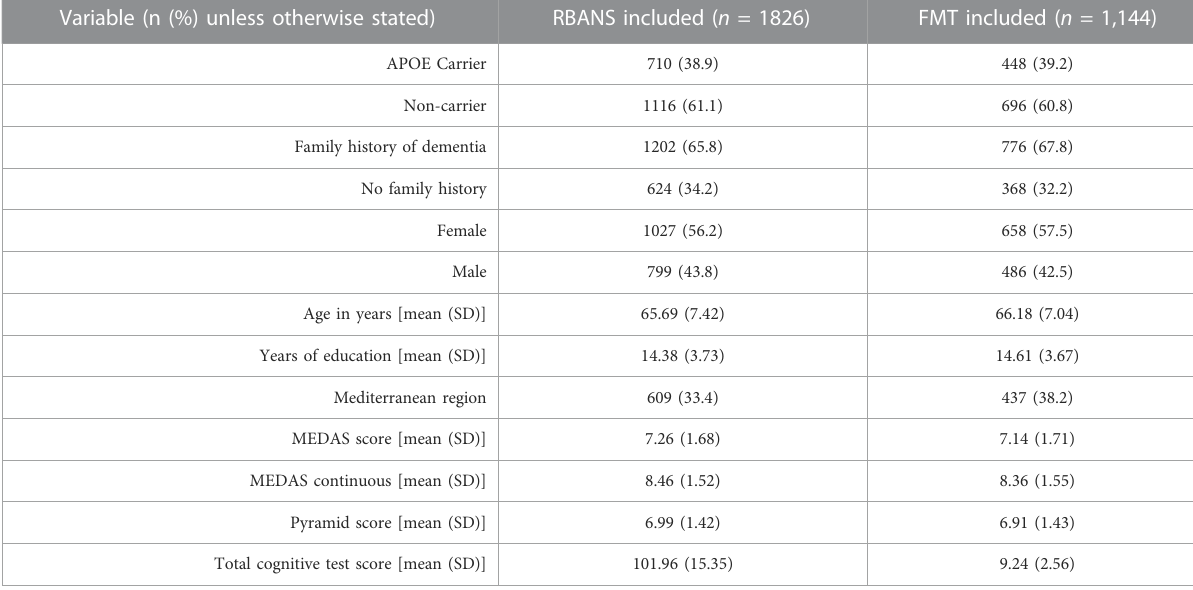
TABLE 1 Descriptive statistics of participants included in the RBANS and Four Mountains Test, FMT analysis. Variable (n (%) unless otherwise stated) RBANS included ( n =